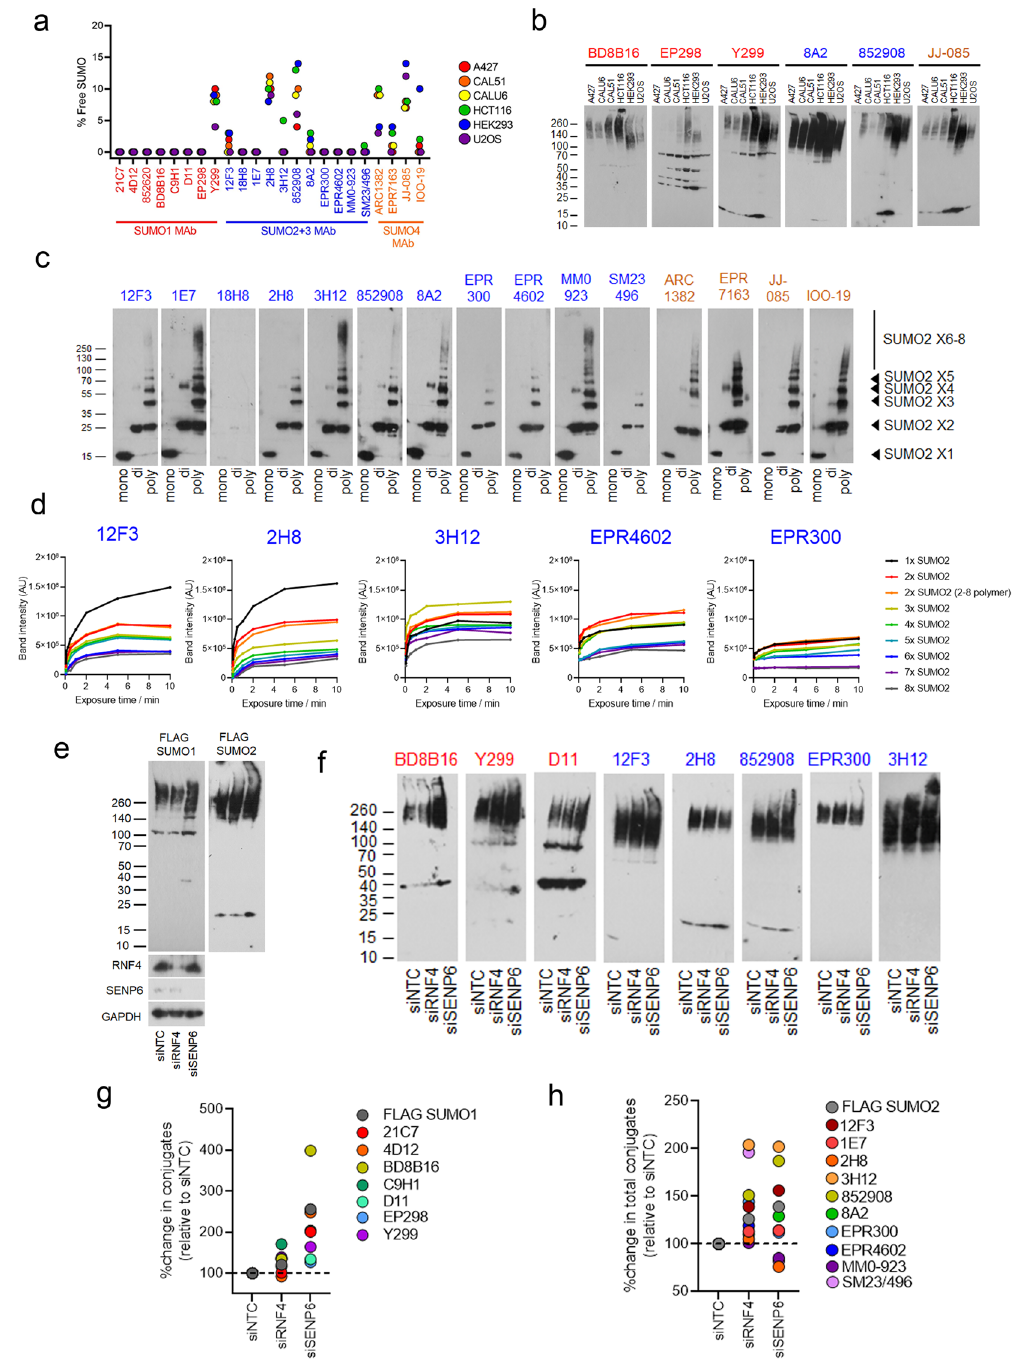
Figure 3. SUMO Mabs vary in ability to detect SUMO conjugate types. (a) The % ~ 15 kDa band (interpreted as free SUMO protein) as a proportion of the total SUMO signal is shown for each of six cell lines, across all MAbs. The % free SUMO is calculated as free SUMO/total SUMO (conjugates and free) × 100 (blots from multiple exposures were quantified and averaged to ensure the linearity of the signal). N = 3. ( b) Representative blots of lysates from indicated cell lines, the band at ~ 15 kDa is interpreted as free SUMO. Images for all cell lines and exposures can be found in supplemental Fig. 3A. ( c) Immunoblots of SUMO2 monomers, dimers, and polymers (2–8 × SUMO2) at 200 ng/lane resolved on 4–20% SDS PAGE gels. Images are from various film exposure times. All exposures can be found in Supplemental Fig. 3b. ( d) Quantification of representative experiments from ( c) from multiple exposure times. ( e) Immunoblots of U2OS FLAG-SUMO1 or FLAG-SUMO2 cells, siRNA treated as indicated and doxycycline-treated for 48 h to replace endogenous SUMO with FLAG-SUMO. Immunoblots of RNF4 and SENP6 siRNAs are shown. ( f ) Representative immunoblots FLAG-SUMO complemented U2OS lysates from ( e ) probed with representative SUMO1 MAbs (red) and SUMO2/3 MAbs (blue). Blots for all MAbs are shown in the uncropped membrane section in the supplemental data. ( g) The % change in the total signal detected by antibodies raised to SUMO1 following siRNA depletion of RNF4 and SENP6 relative to non-targeting (NTC) siRNA control in the cell lines shown N = 3. ( h) The % change in the total signal detected by antibodies raised to SUMO2/3 following siRNA depletion of RNF4 and SENP6 relative to NTC siRNA control in the cell lines shown N =